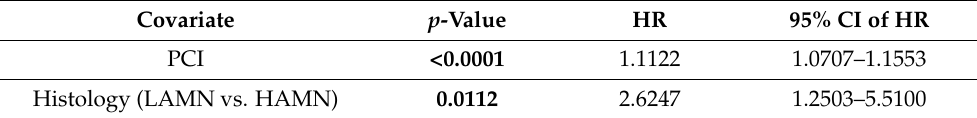
Table 5. Multivariate Cox regression for PFS. HR: hazard rate, CI: confidence interval. Covariate Histology (LAMN vs.